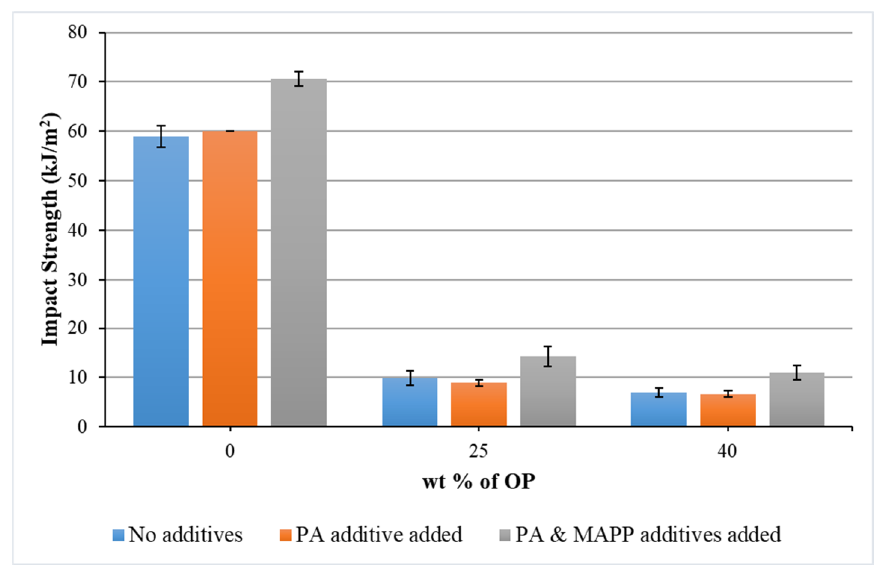
Figure 9. Results of the Charpy impact tests of biocomposites as a function of percentage by weight of OP, considering materials without additives, adding PA and adding PA and MAPP, respectively.